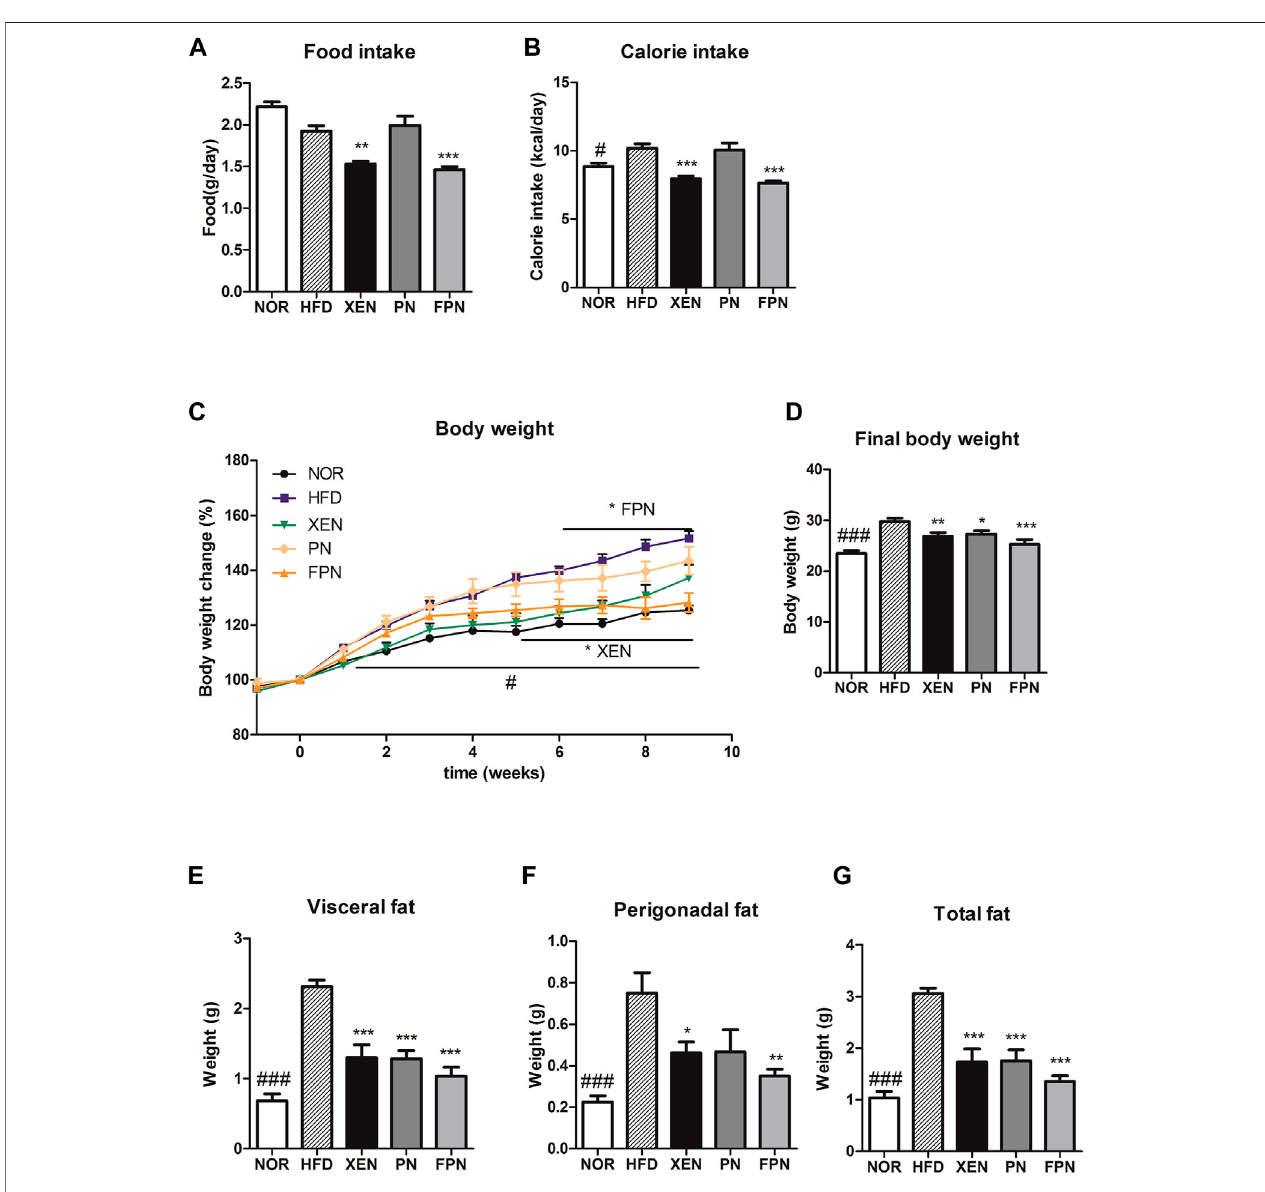
FIGURE 3 | Effect of PN and FPN on the body and fat weight and food intake in a HFD-induced mouse model after treatment for 9 weeks. (A) Food intake, (B) calorie intake, (C) body weight, (D) fi nal body weight, (E) visceral fat weight, (F) perigonadal fat weight, and (G) total fat weight. The data are expressed as the mean ± SEM ( n (cid:2) 7 – 8); # p < 0.05; ### p < 0.001; NOR vs. HFD group. * p < 0.05; ** p < 0.01; *** p < 0.001; HFD group vs. treatment groups (XEN, PN and